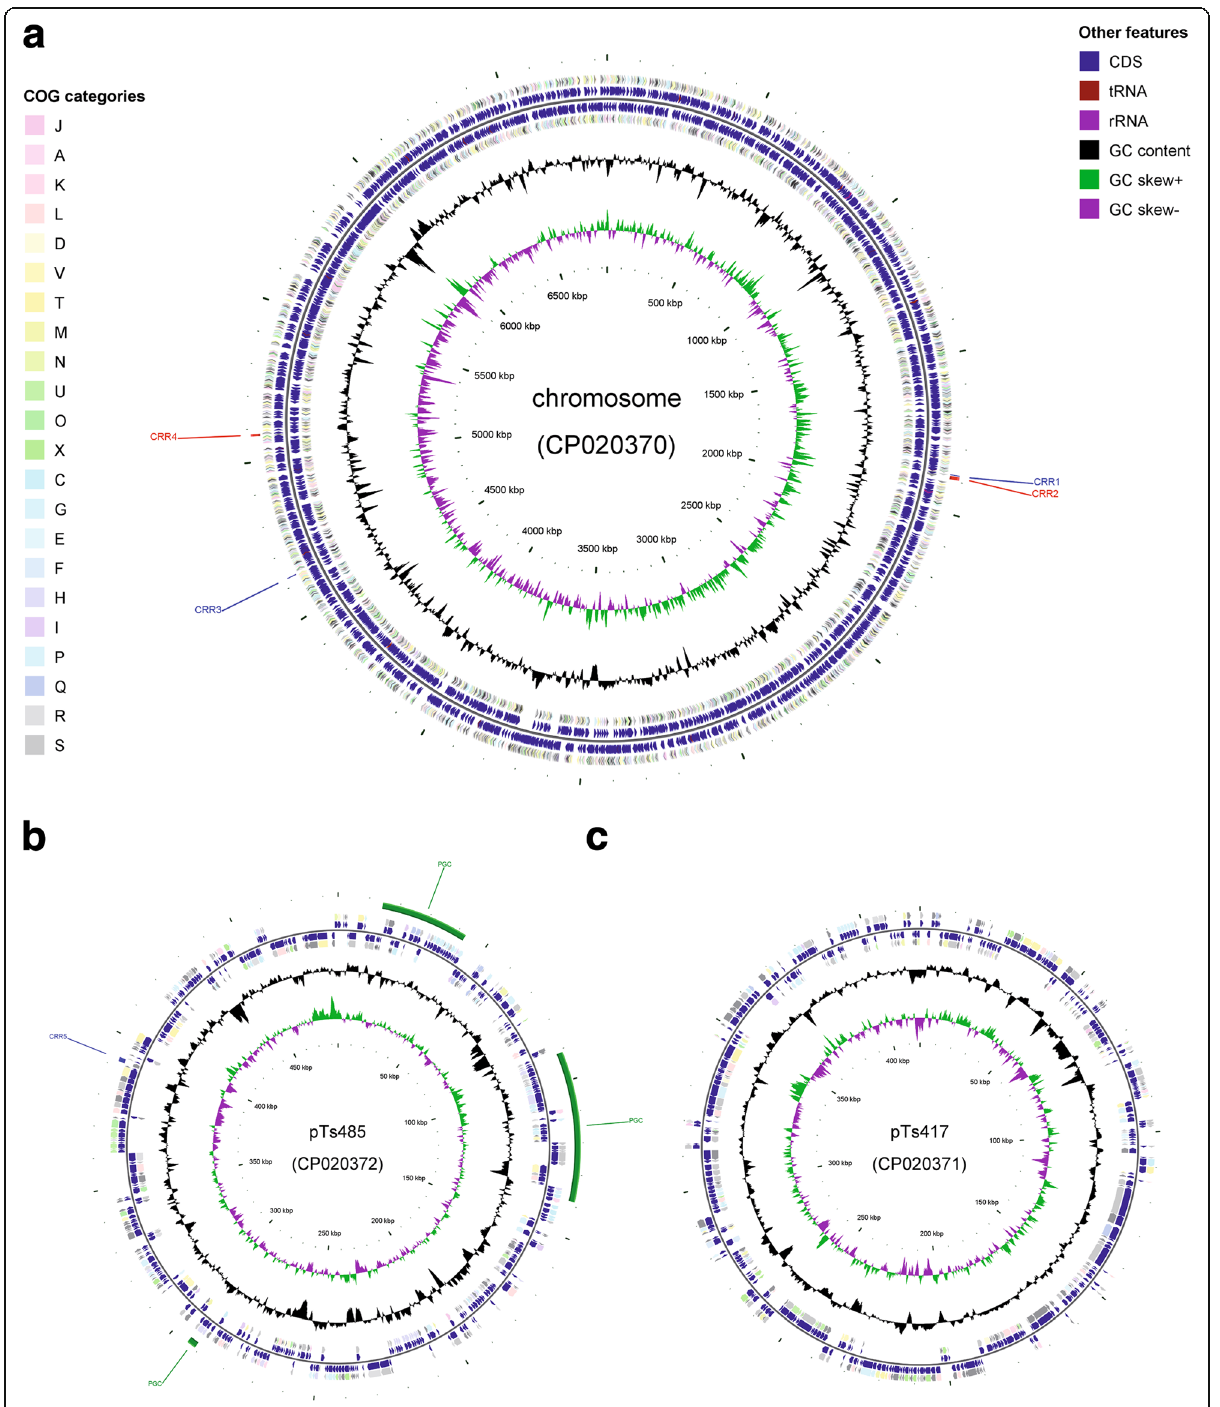
Fig. 3 Schematic representation of the complete genome sequence of “ Thiodictyon syntrophicum ” sp. nov. strain Cad16 T and gene classification according to the COG criteria. The genome comprises one circular chromosome ( a ) and two circular plasmids, pTs485 ( b ) and pTs417 ( c ). Beginning with the outermost circle, tracks are shown in the order of: (1) predicted PGC on pTs485 (green), (2) CRISPR arrays on the chromosome and pTs485 (alternating in blue and red) (3) protein coding genes on forward strand colored according to COG categories, (4) CDS (blue), tRNA (orange) and rRNA (violet) on forward strand, (5) CDS (blue), tRNA (orange) and rRNA (violet) on reverse strand, (6) protein coding genes on reverse strand colored according to COG categories, (7) GC content (black), (8) positive and negative GC skew (green and purple, respectively) and (9) genome region by kbp. GCView [63] was used to create this genome